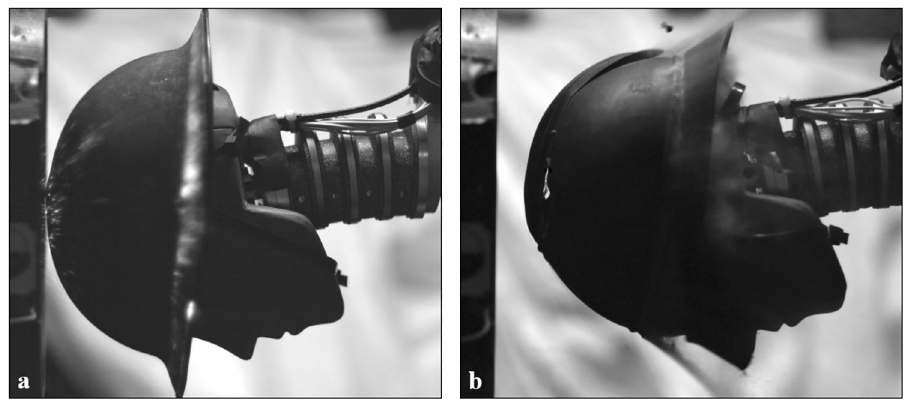
Fig 7. High speed frames of blast impact on the head. Frames from high speed video recording of high intensity blast tests immediately after blast wave impingement on the (a) Brodie helmet and (b) Adrian helmet.